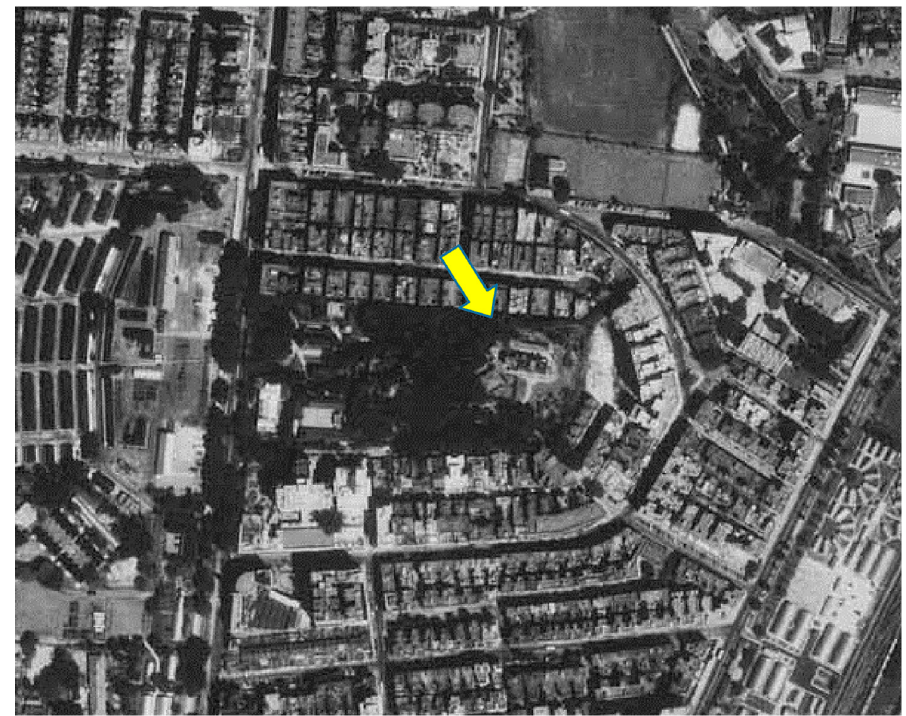
Figure 8. Buildings surrounding the HKO headquarters in October 1959.